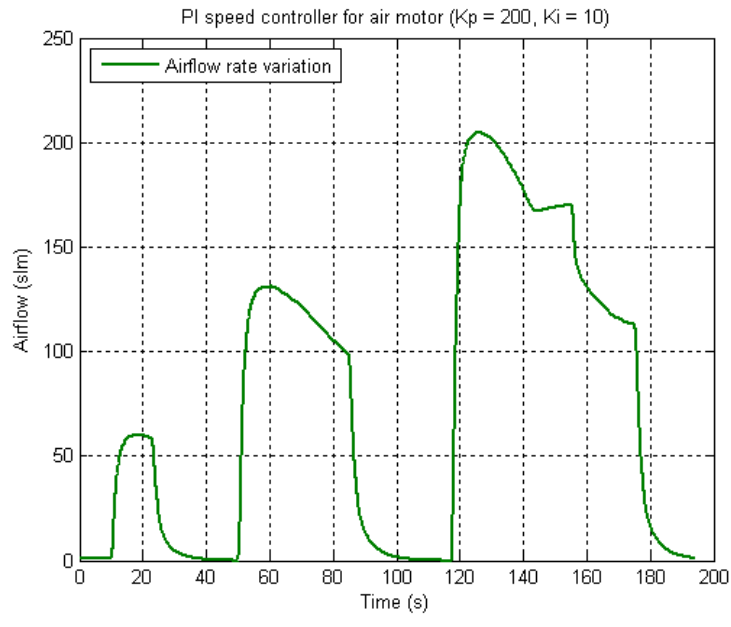
Figure 9. The air consumption of the driving cycle